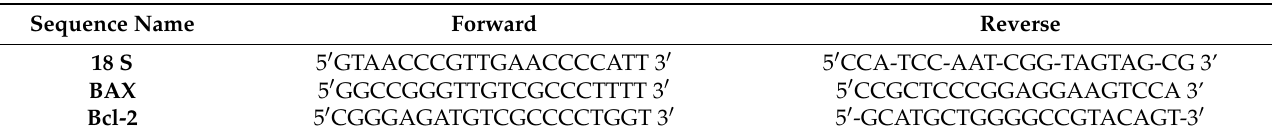
Table 2. Primer pair used in rtPCR